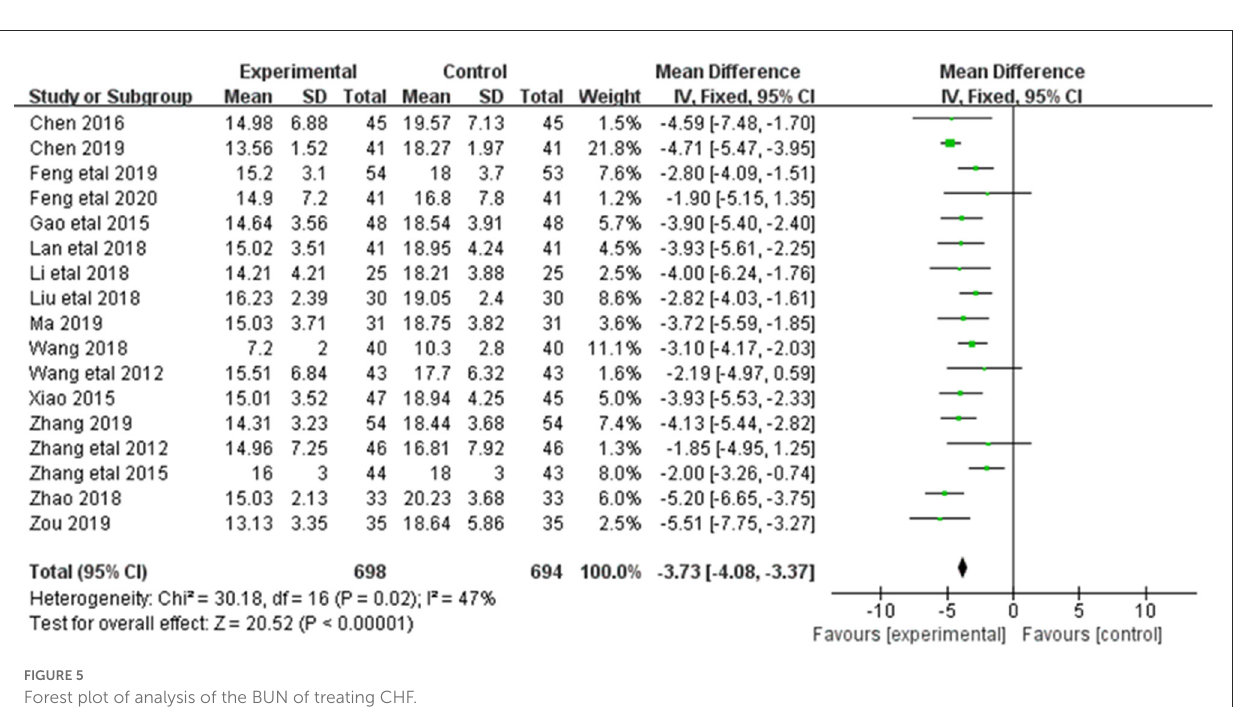
= 0.2, 95% CI = (0.16, 0.25)], with statistical